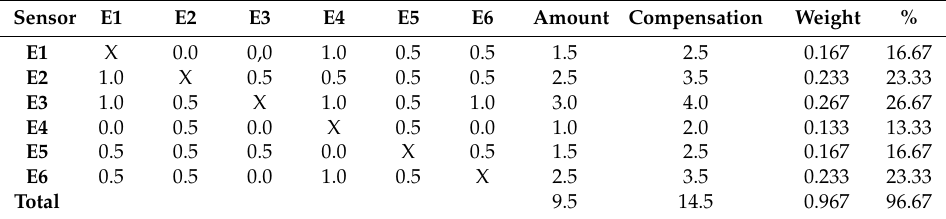
Table 1. Filament detection sensor evaluation.